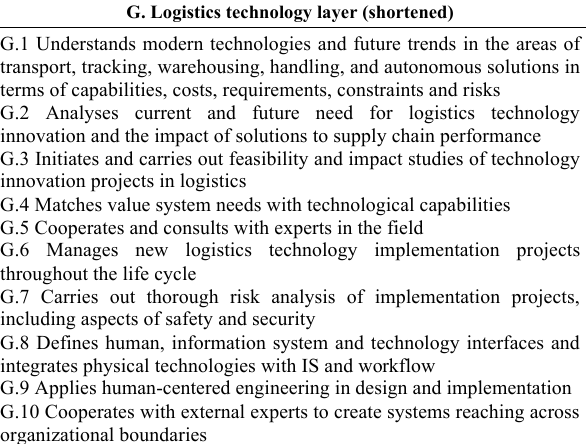
TABLE III. F OUNDATIONAL C OMPETENCE L AYERS IN THE P ROFILE G. Logistics technology layer